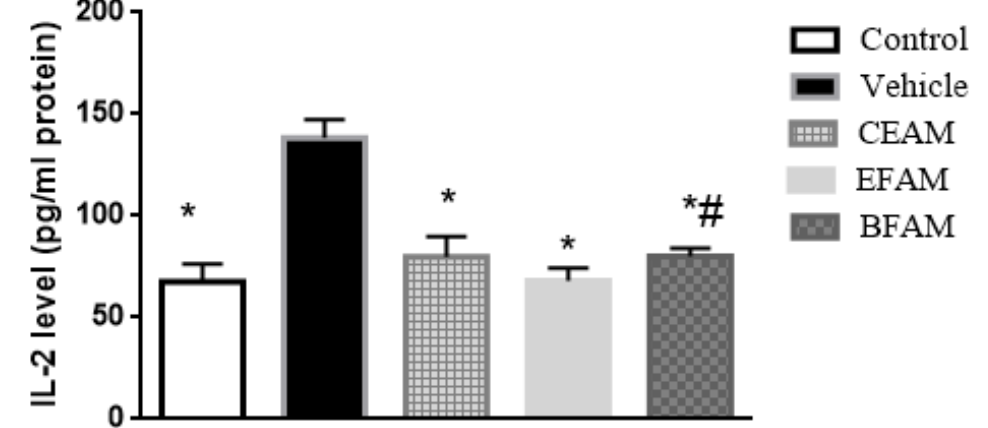
Figure 5. Effect of A. maurorum extract and fractions on tongue tissue IL-2 level in rats subjected to acetic acid-induced tongue ulcers compared with the vehicle group. * p < 0.05 vs. vehicle group and # p < 0.05 vs. EFAM group using One-way ANOVA followed by Tukey–Kramer as a post hoc test. Results are shown as mean ± SD ( n = 6).